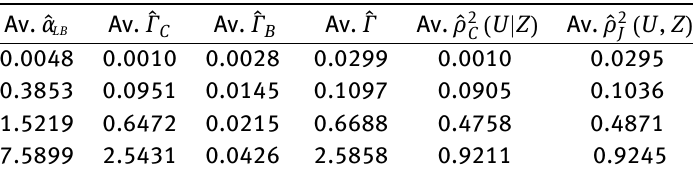
Table 4: Av. estimated information gain and dependence measure given simulated length-biased data, using parametric copula method, for N = 5000, n = m = 1000, r = 4 and p = 2 .